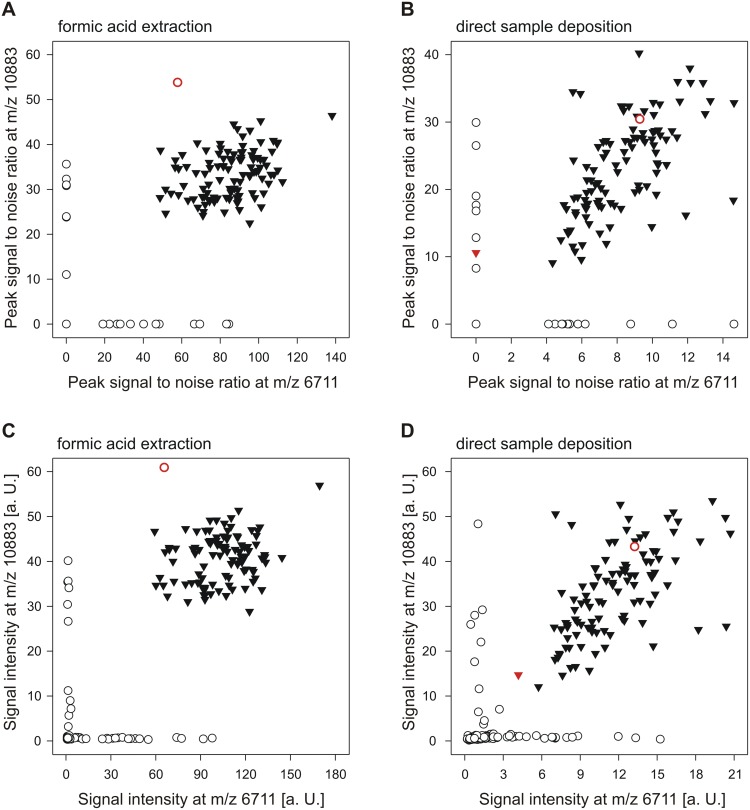
Marker peak characteristics in spectra from study isolates.Mean signal to noise ratio of outbreak strain marker peaks (A, B) and mean signal intensitiy (C, D) at marker peak position in formic acid extraction (A, C) and direct sample deposition (B, D) triplicate spectra from 293 study isolates. Black triangles and white circles represent measurements from 104 outbreak and 189 non outbreak E. coli isolates, respectively. Red colour indicates misidentified isolates.